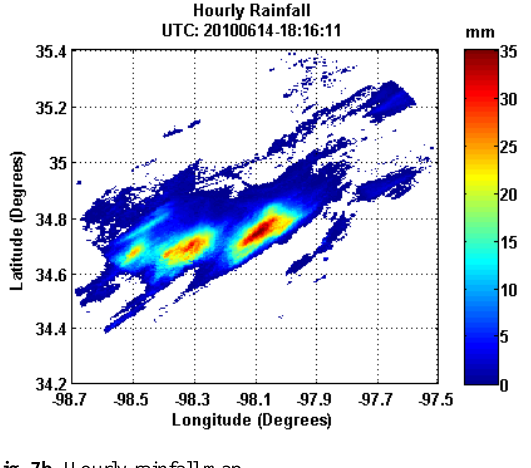
Fig. 7b. Hourly rainfall map.